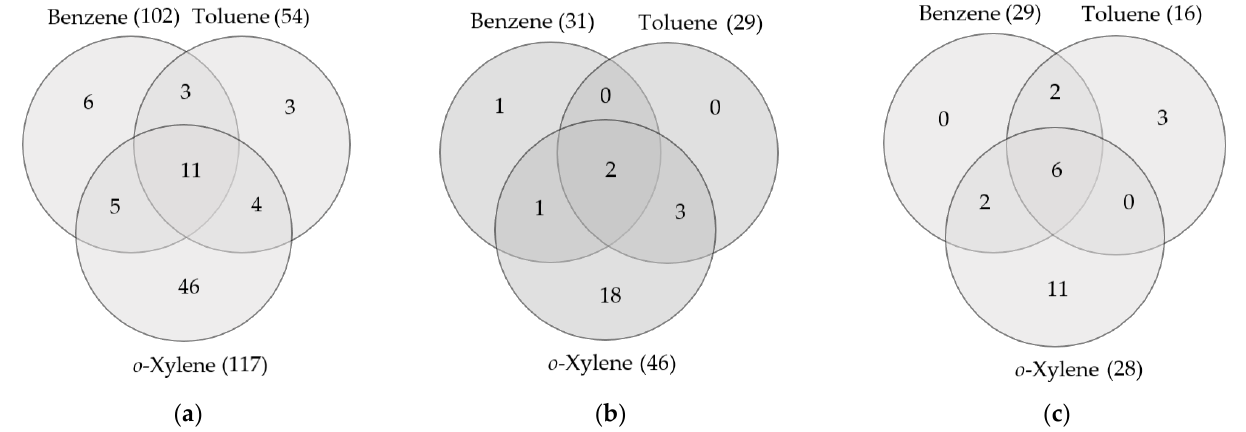
Figure 2. Substrate specificities of Rhodococcus strains toward monoaromatic hydrocarbons. Total numbers of strains tested toward specific hydrocarbons are shown in brackets. Numbers of strains growing only in the presence of benzene, toluene, or o- xylene are shown in non-overlapping areas of circles. The numbers of strains able to use two or all three hydrocarbons as the sole carbon and energy sources are shown in overlapping areas of circles. ( a ) Rhodococcus spp. ( b ) R. erythropolis/R. gingshengii strains. ( c ) R. ruber strains.